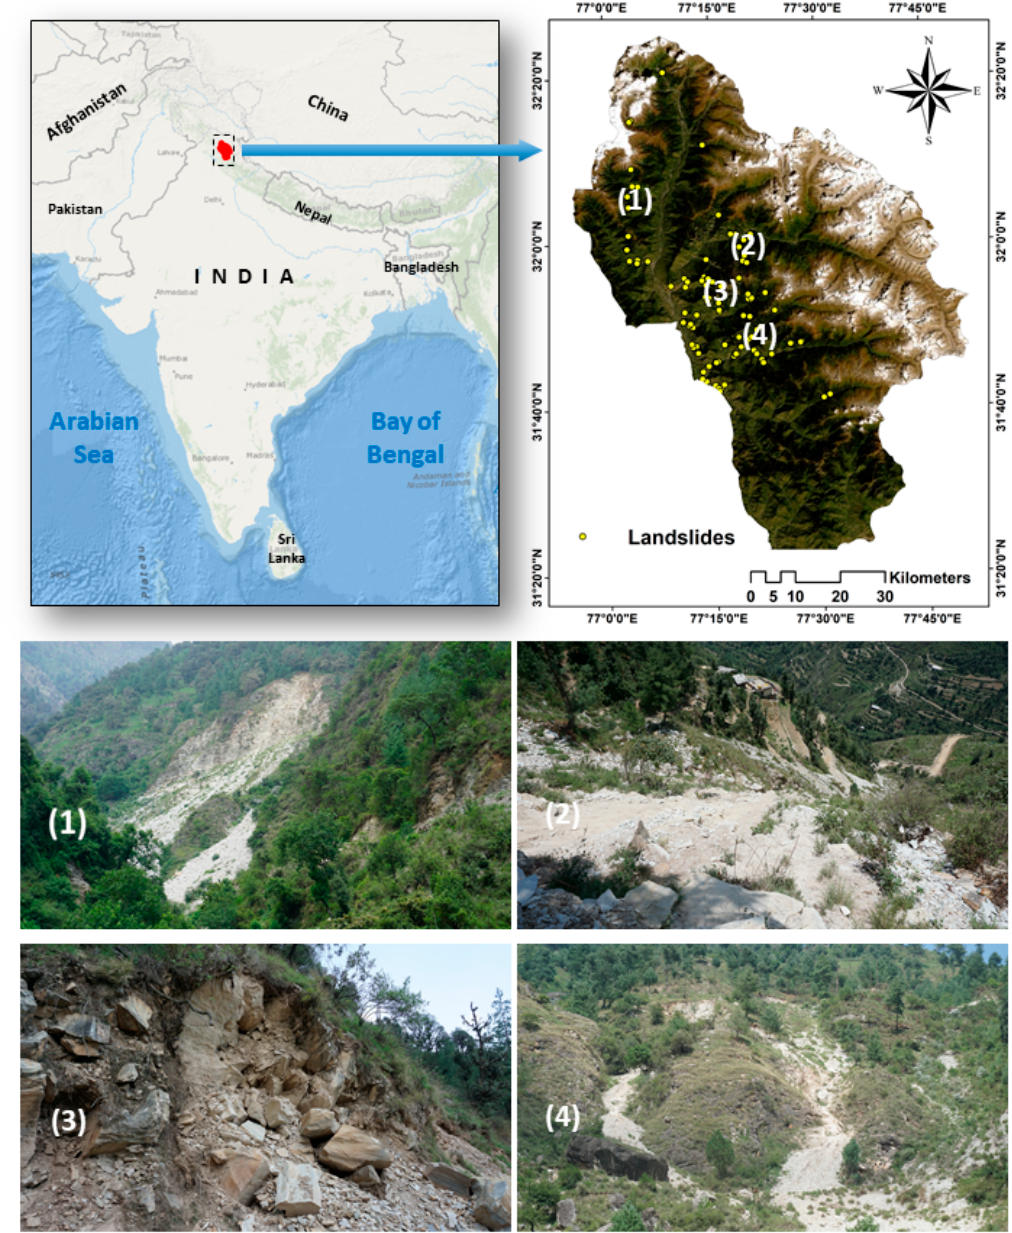
Figure 1. Map shows the location of the study area and the field photographs showing active landslides. ( 1 ) Phallan ( 2 ) Jallu ( 3 ) Kandi ( 4 ) Devgarh Gohi.